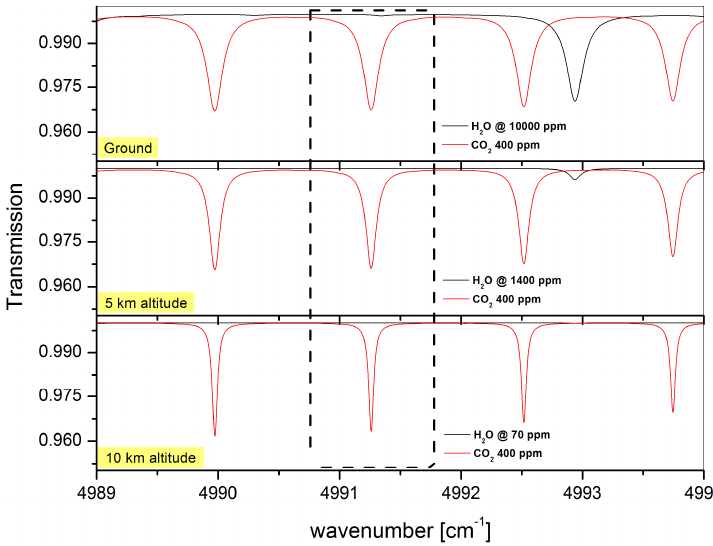
Figure 2. Simulated absorption spectra ranging from 4989 cm − 1 to 4994 cm − 1 for an optical